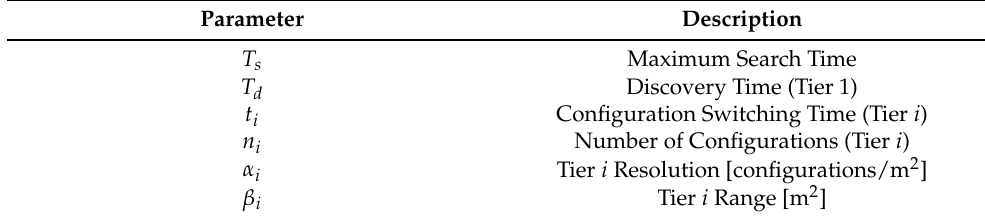
Table 1. MTH analysis